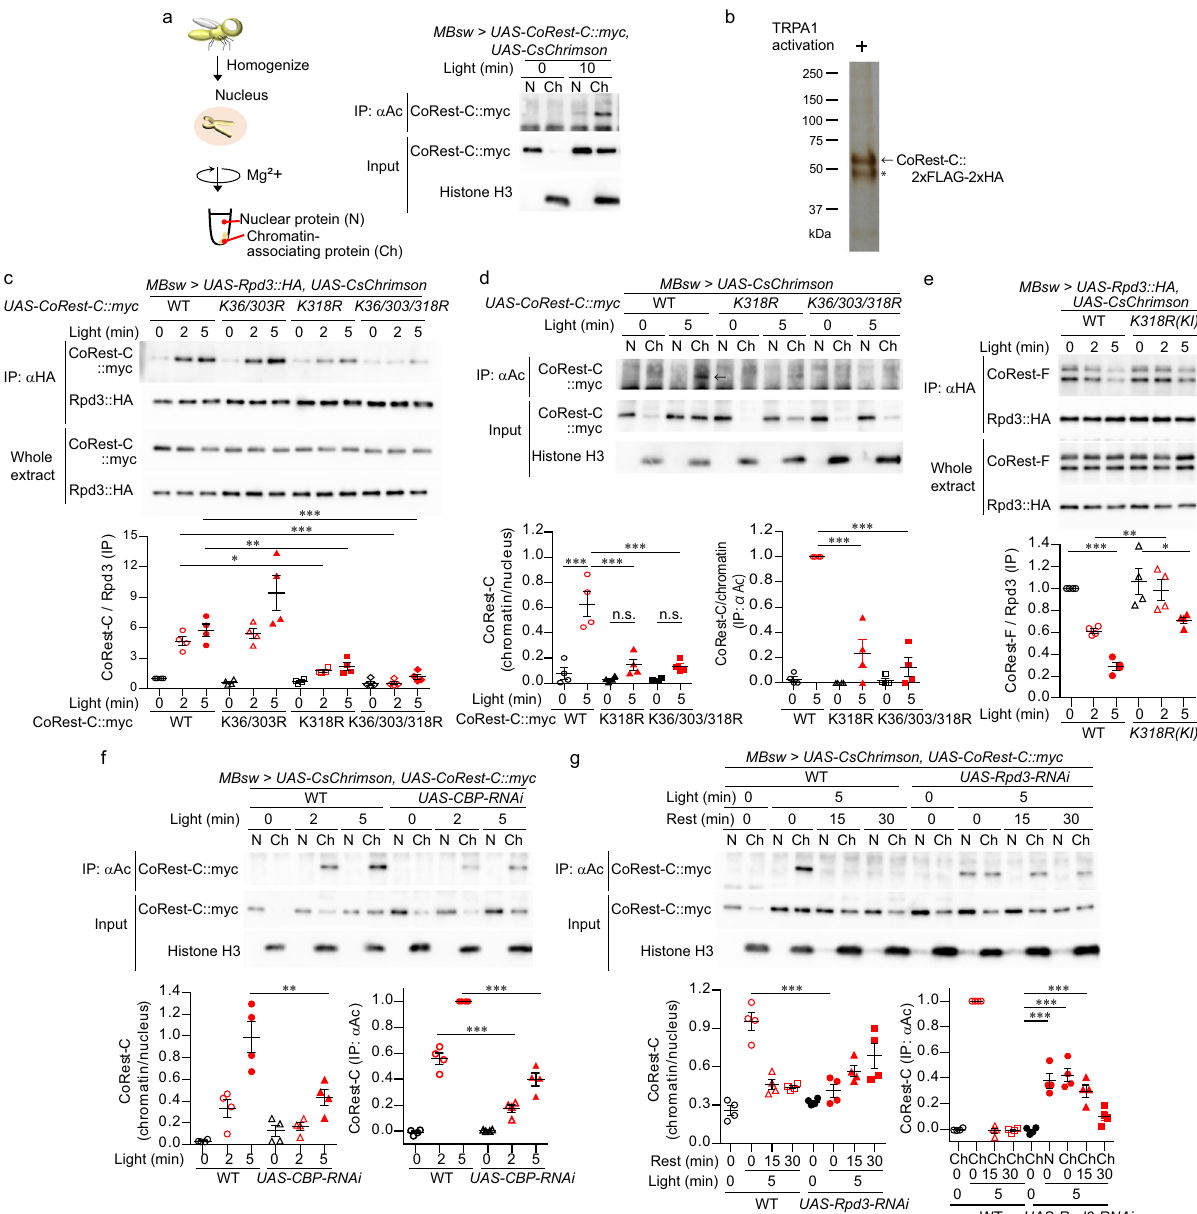
Fig. 5 Acetylation of CoRest-C is important for binding to Rpd3. a , d Acetylated CoRest-C was localized on chromatin after optogenetic activation. The fl ies carrying the indicated transgenes were fed RU, and illuminated with red light. Nuclear extracts prepared from the heads were separated into the nuclear proteins (N) and the chromatin-associating proteins (Ch) by centrifugation in the presence of Magnesium (Mg 2 + ). Each fraction was immunoprecipitated with an anti-Acetyl lysine antibody ( α Ac). The antibodies for the indicated epitope tags or for histone H3 were used in a western blot analysis. a The images are representative of three experimental replicates. d A one-way ANOVA ( P < 0.0001; n = 4 for all) followed by Tukey ’ s multiple comparisons (two sided) was performed. The arrow indicated CoRest-C::myc. b Puri fi ed CoRest-C proteins from MB neurons. CoRest-C::FLAG-HA was expressed by MBsw, together with dTRPA1. The fl ies were heat-shocked at 35 °C for 30 min, and the heads were subjected to tandem-tag af fi nity puri fi cation. The proteins were visualized by silver staining. Asterisk indicates the IgGs. c , e CoRest-C binding to and CoRest-F dissociation from Rpd3 after optogenetic activation requires K318 of CoRest-C. The fl ies with the indicated transgenes were fed RU, and illuminated with red light, and the head extracts were immunoprecipitated with the anti-HA antibody. CoRest-F was detected with the anti-CoRest antibody ( e ), and other proteins were detected with antibodies speci fi c to the indicated epitope tags in a western blot analysis. K318R (KI) , CoRest-C-K318R knock-in mutation. A one-way ANOVA ( P < 0.0001; n = 4 for all) followed by Tukey ’ s multiple comparisons (two sided) was performed. f , g Acetylation and deacetylation of CoRest-C is mediated by CBP and Rpd3. The fl ies carrying the indicated transgenes were fed RU, and illuminated with red light and analyzed as in a . A one-way ANOVA ( P < 0.0001; n = 4 for all) followed by Tukey ’ s multiple comparisons (two sided) was performed. Data are represented as mean ± s.e.m. n.s., not signi fi cant, P > 0.05; * P < 0.05; ** P < 0.01; *** P < 0.001, which is based on experimental replicates using different pooled samples, and the number is indicated as n above. Source data are provided as a Source Data fi